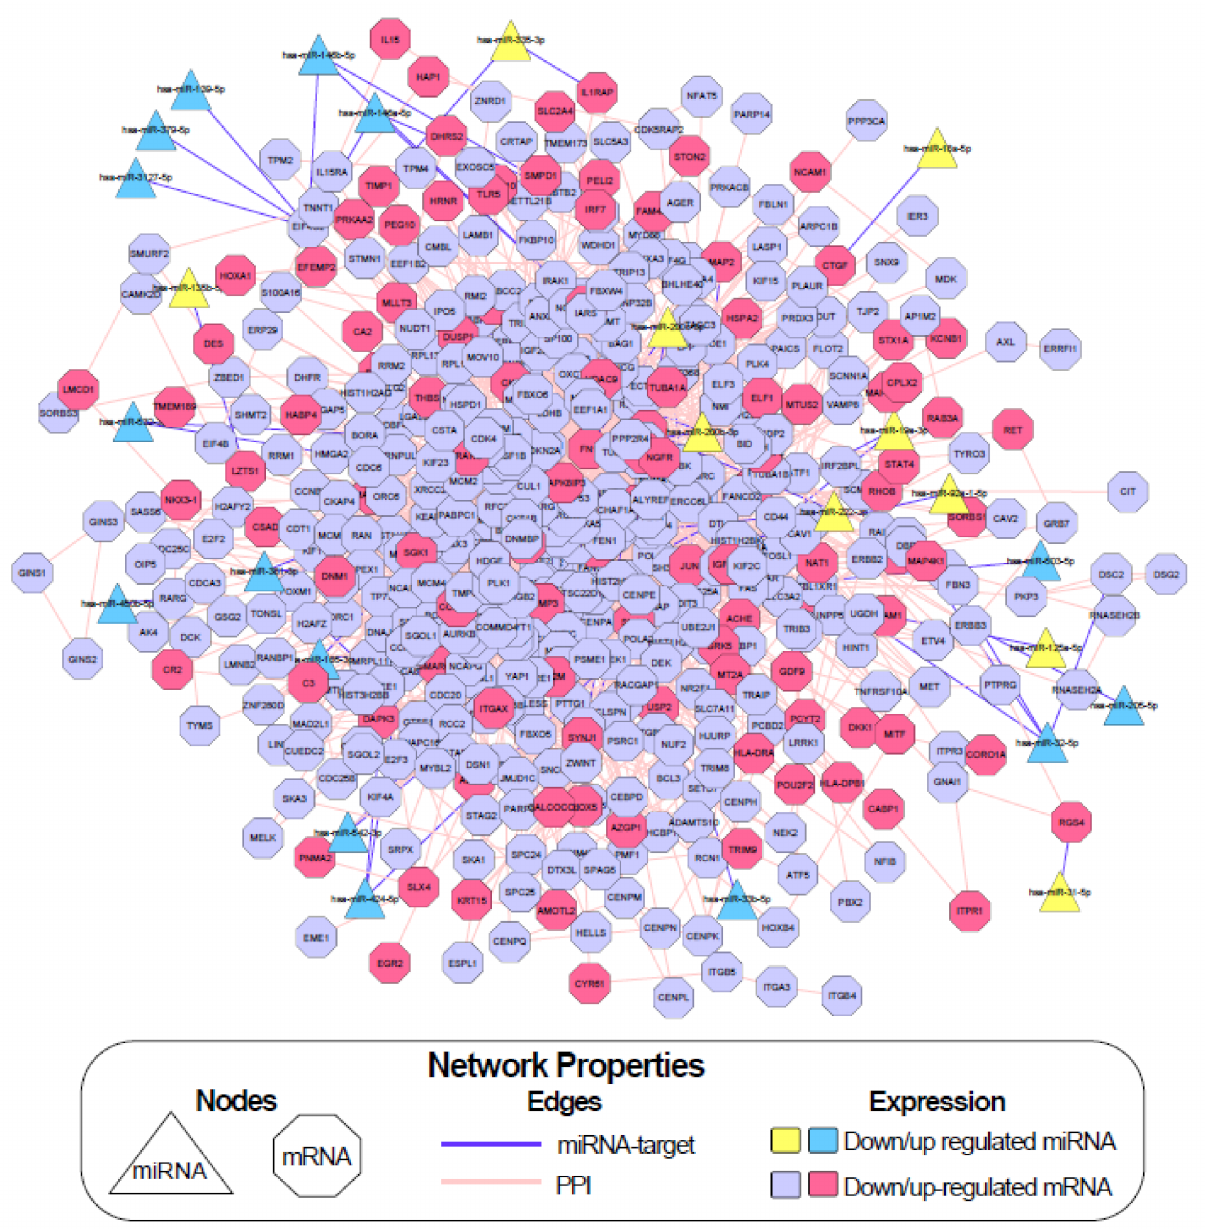
Figure 5. Butyrate-regulated integrative miRNA-mRNA network constructed using Cytoscape based on interactions between miRNA and target protein-coding genes and PPI. Refer to the key for node information and expression profiles. The color of the node represents the expression changes due to 2.5 mM butyrate treatment, and the shape represents the type of molecule for each node. Solid lines are edges and represent direct interactions between two